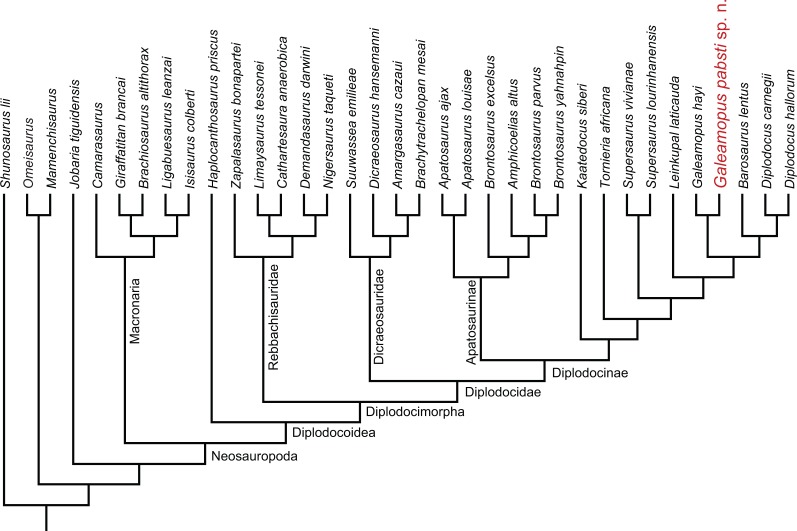
Single tree with best fit of the phylogenetic analysis under implied weighting (k = 5).The analysis is based on an updated matrix of Tschopp, Mateus & Benson (2015), transformed to a species-level analysis. Galeamopus pabsti sp. n. is recovered within Diplodocinae, as sister taxon to Galeamopus hayi. Note that the position of Amphicoelias altus among the species of Brontosaurus is dubious (see text).